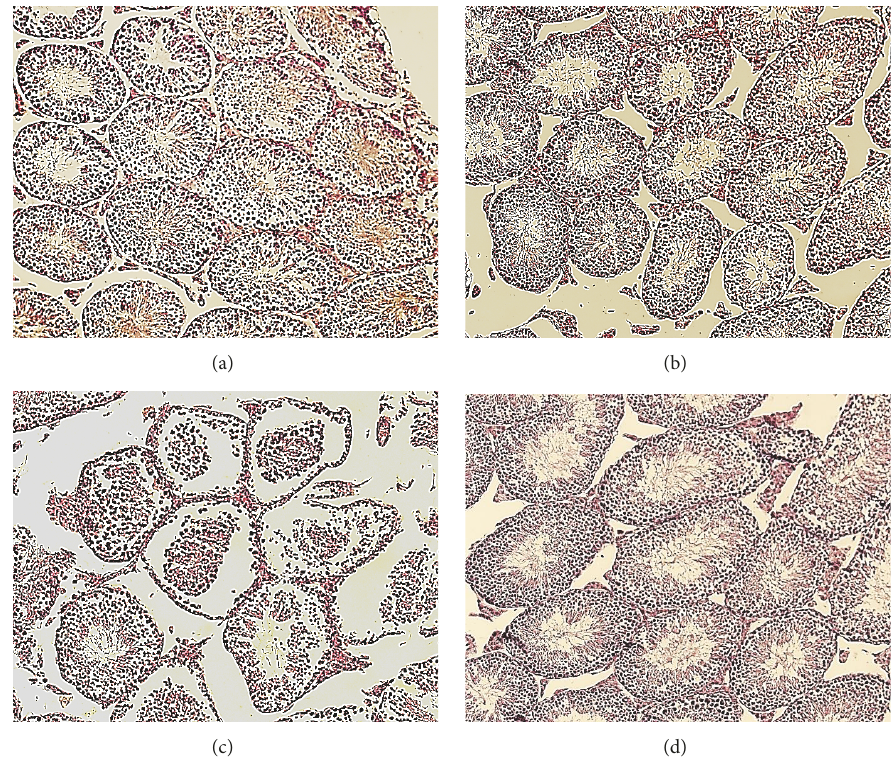
Figure 7: Testicular sections of adult male offspring in the different groups: (a) control group, (b) vehicle group, (c) mancozeb-treatedgroup, and (d) vitamin E + mancozeb-treated group (H&E staining, magnification: ×